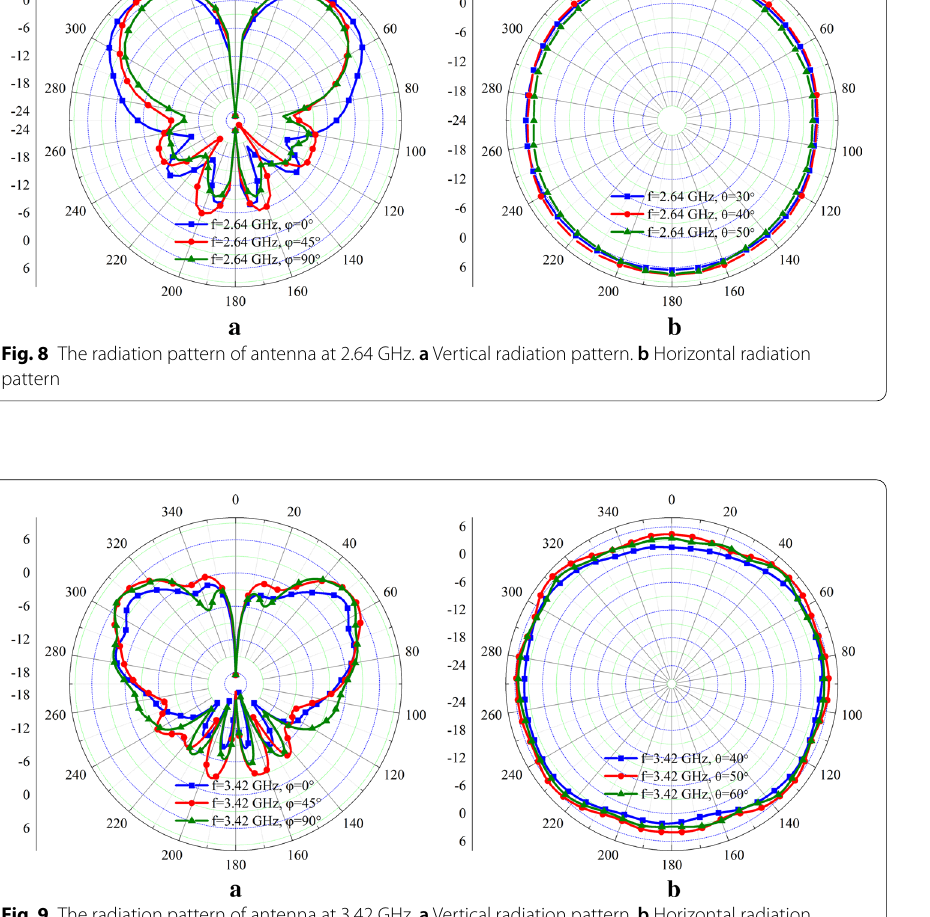
Fig. 9 The radiation pattern of antenna at 3.42 GHz. a Vertical radiation pattern. b Horizontal radiation